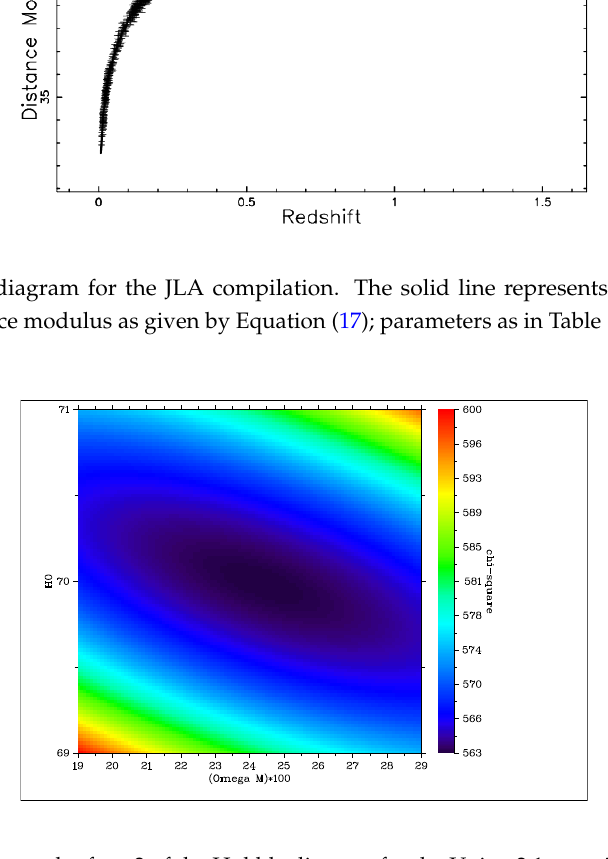
Figure 7. Color contour plot for χ 2 of the Hubble diagram for the Union 2.1 compilation when H 0 and Ω Ω Λ M are variables and (cid:16)